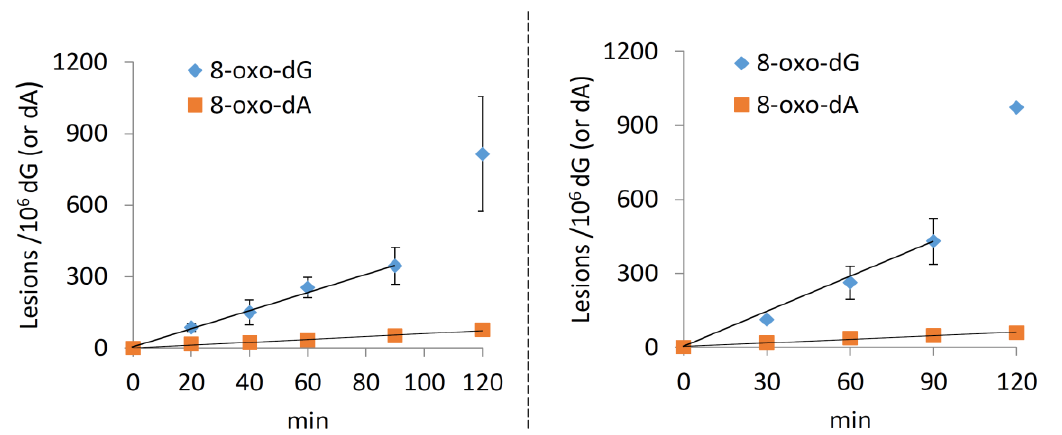
Molecules 2019 , 24 , x FOR PEER REVIEW 13 of 20 Figure 13. Kinetic study by Fenton reaction. (A and B): CuCl 2 /H 2 O 2 /Ascorbate-induced formation of 5 ′ R -cdG, 5 ′ S -cdG, 5 ′ R -cdA and 5 ′ S -cdA at 0, 20, 40, 60, 90 and 120 min. ds-(ODN5/ODN6) treated with CuCl 2 (15 µM), H 2 O 2 (120 µM), Ascorbate (1.2 mM); (C and D): Fe 2+ /H 2 O 2 /Ascorbate-induced formation of 5 ′ R -cdG, 5 ′ S -cdG, 5 ′ R -cdA and 5 ′ S -cdA at 0, 30, 60, 90 and 120 min. ds-(ODN5/ODN6)